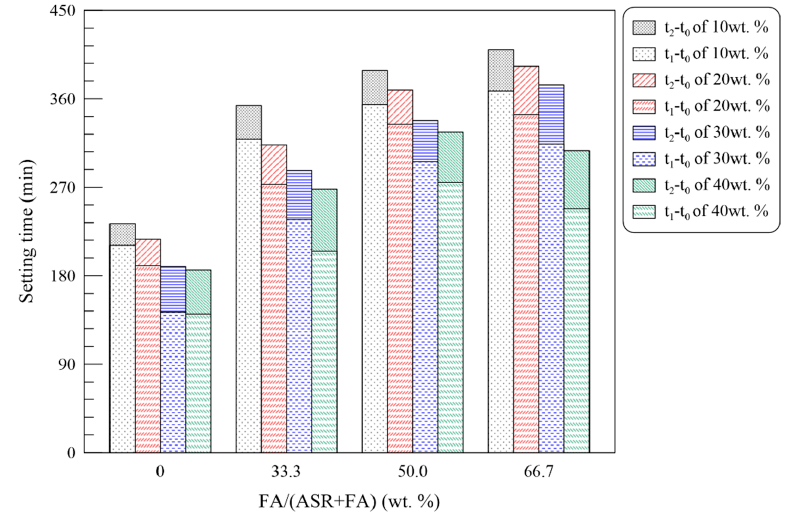
Figure 10. Setting time of MOC pastes with solid wastes. Table 5. Properties of hardened MOC pastes with solid wastes.